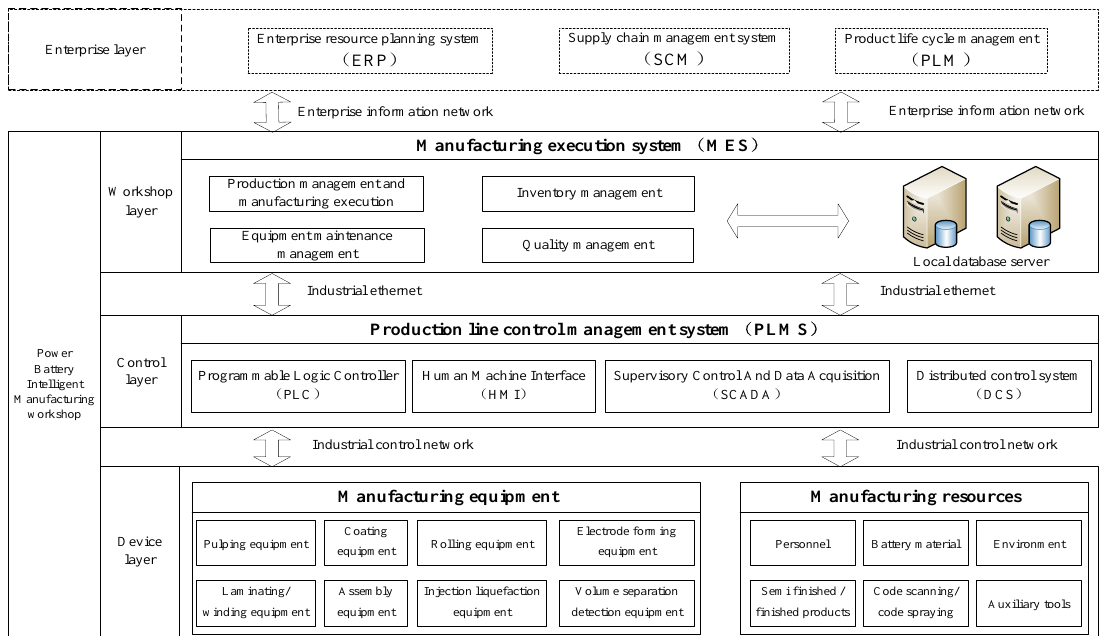
Figure 2. Organization structure schematic diagram of lithium ion battery intelligent manufacturing workshop.